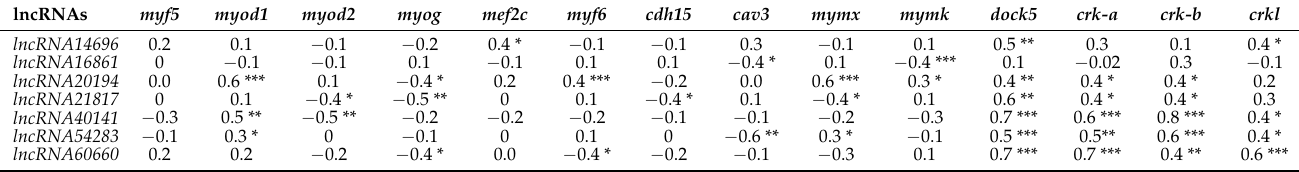
Table 2. Correlation between gilthead sea bream lncRNAs and fast muscle-related